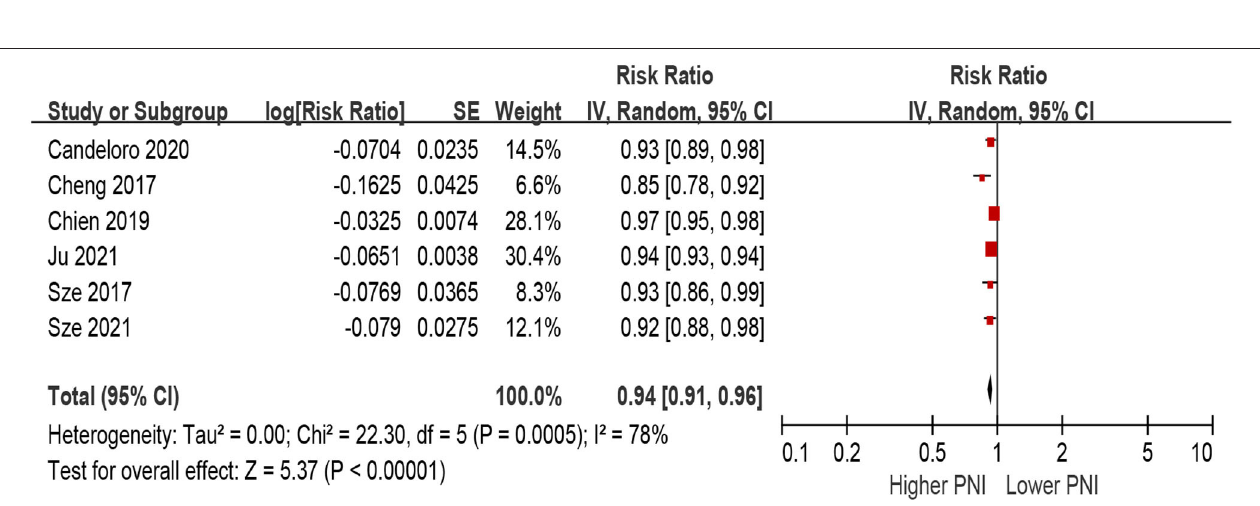
FIGURE 4 | The association between PNI (defined as per 1 increment) and the risk of all-cause mortality in HF (unadjusted model). CI, confidence interval; HF, heart failure; PNI, prognostic nutritional index.